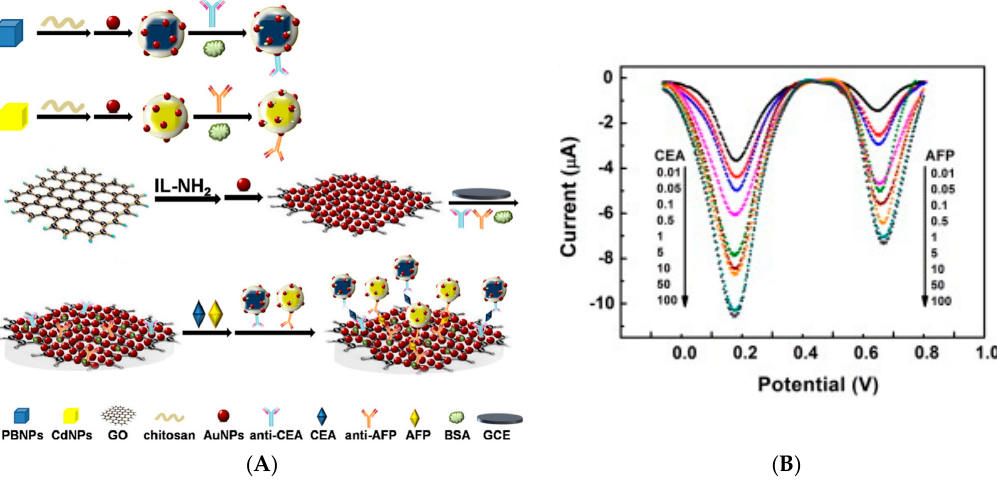
Figure 34. ( A ) CEA and AFP immunosensor based on metal NPs and Prussian blue NPs immobilized on IL-modified GO sheets; ( B ) DPV responses for different concentration of CEA and AFP in PBS, pH